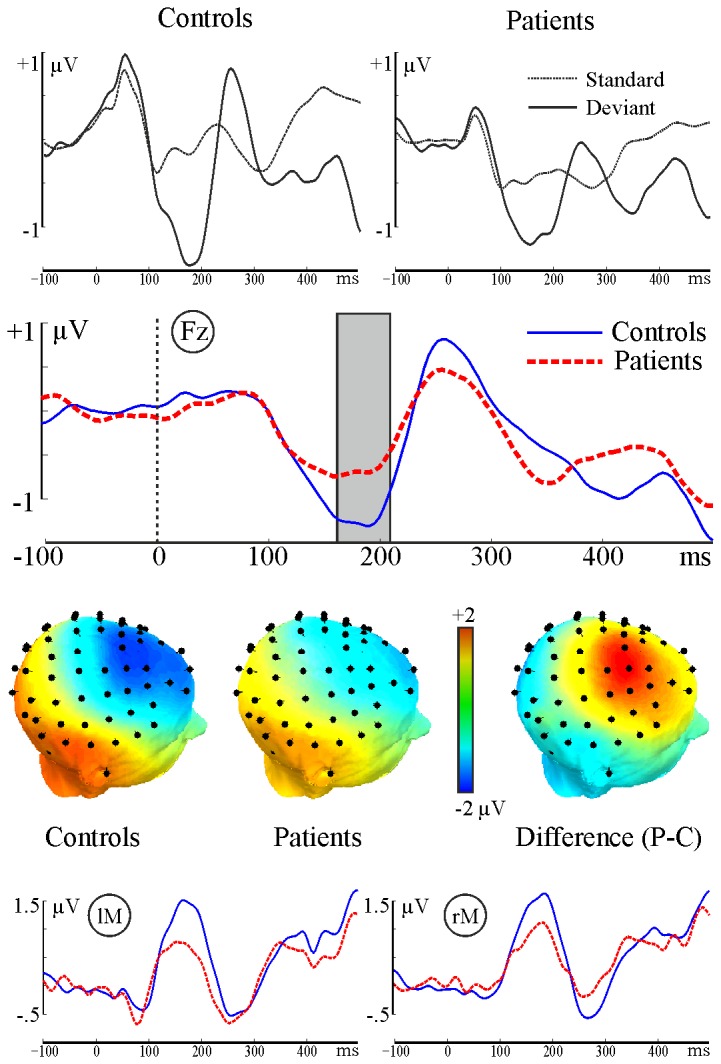
MMN waveforms and topographic headplots.First row: Standard and deviant waveforms from electrode Fz for Controls and Patients. Second row: MMN waveforms from electrode Fz for Controls and Patients. Significant differences were found in the marked (170-210ms) time interval. Third row: topographic headplots for two groups and their difference from the significant time interval (170-210ms). Electrodes with significant effects are marked by white disks. Fourth row: Difference waves from the mastoid electrodes.